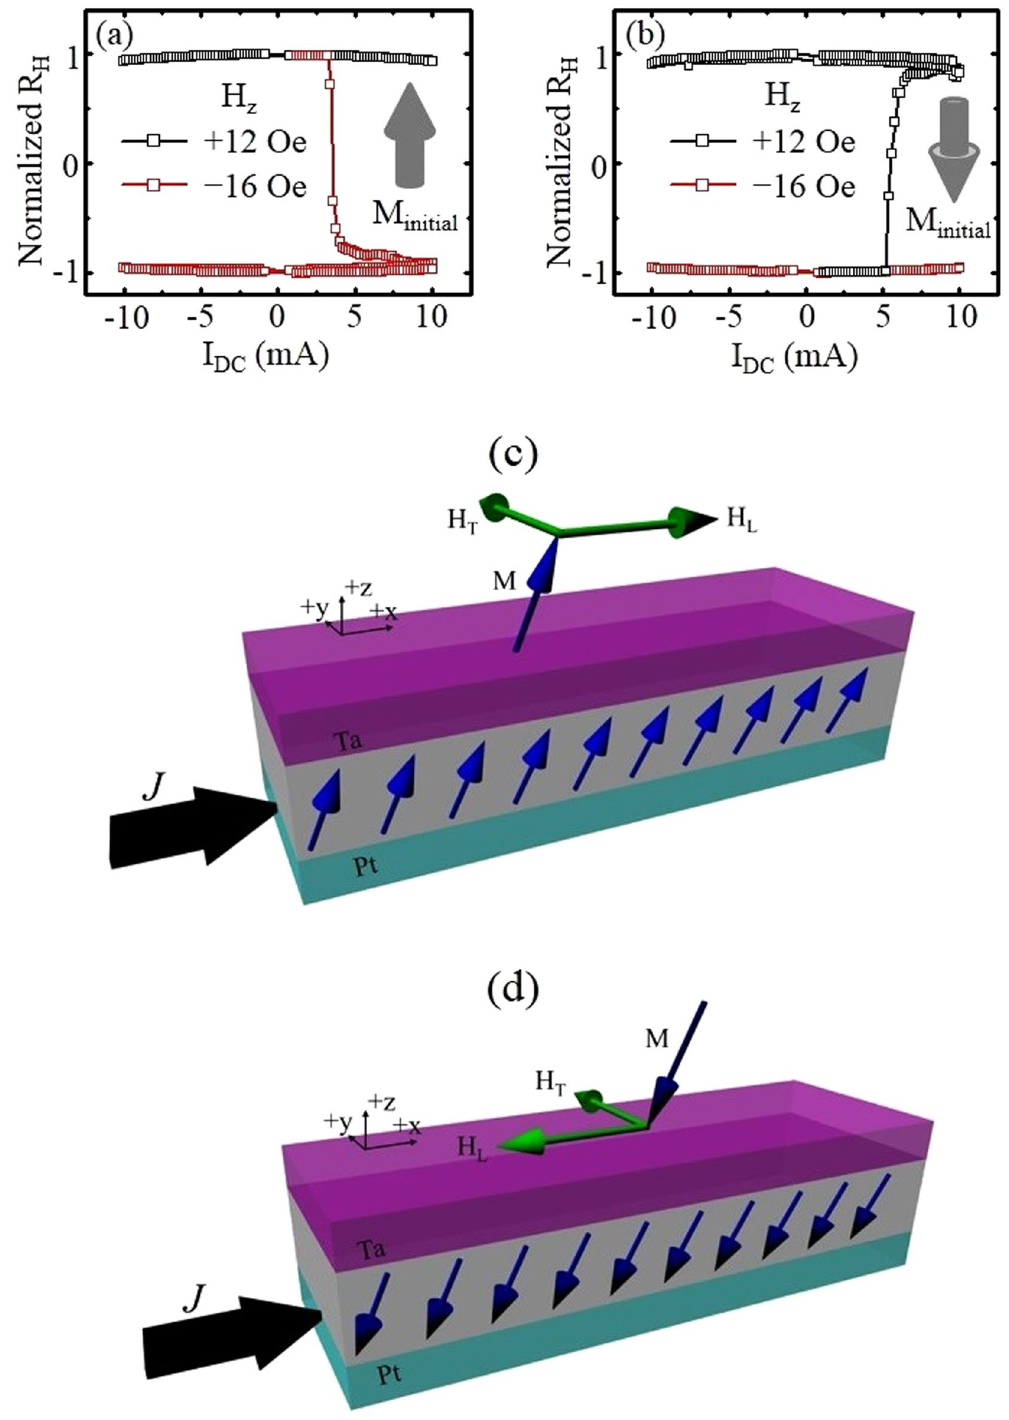
Figure 4. Tilting of the magnetization: Measured R H as a function of the DC current with a small fixed out-of- plane magnetic field along the + z or − z directions for ( a ) up and ( b ) down initial magnetization states. ( c ) and ( d ) are the schematic magnetic configurations corresponding to ( a ) and ( b ),